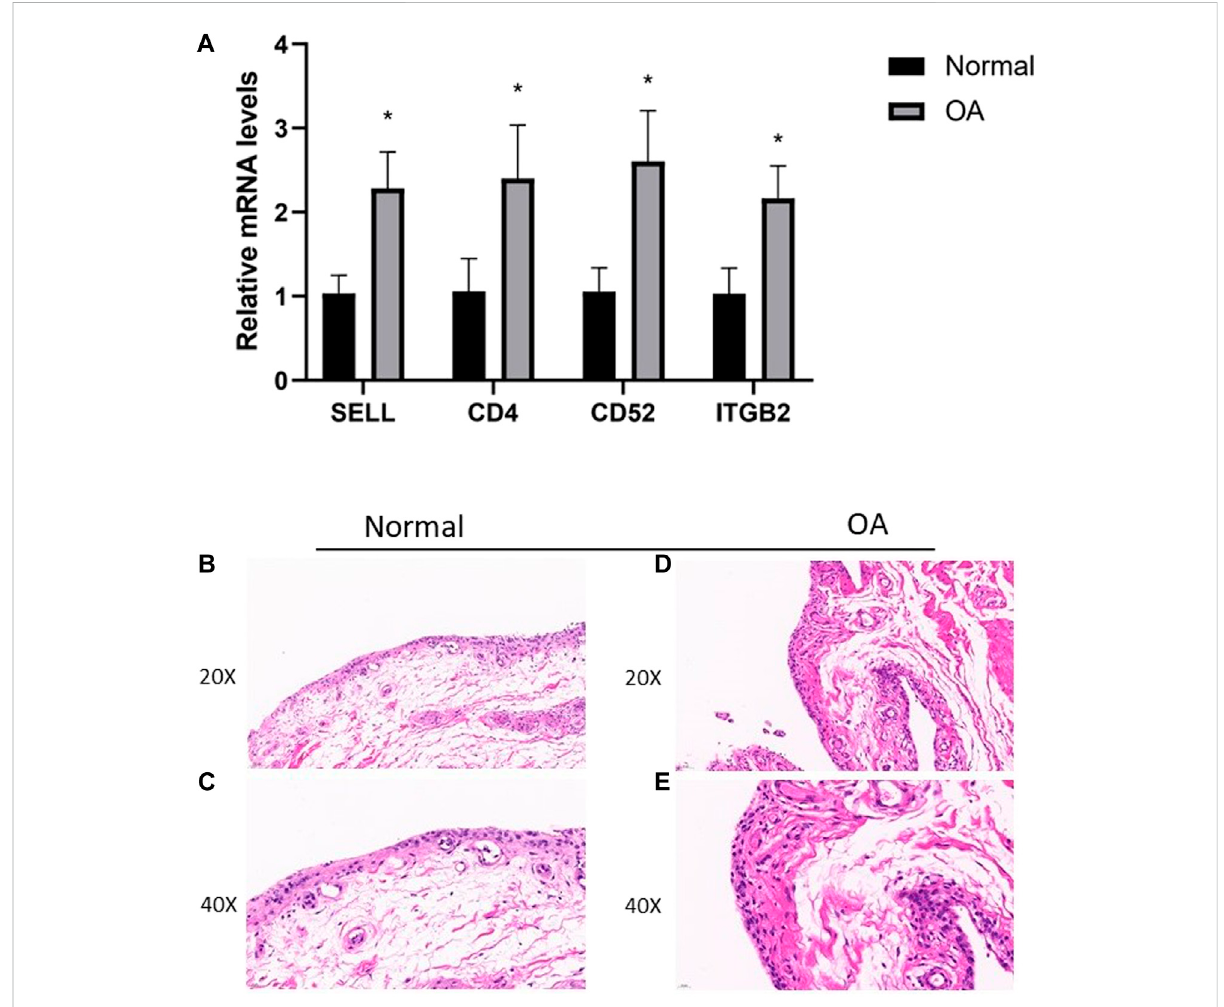
FIGURE 7 (A) RT-PCR validation of hub genes in human primary culture fi broblast-like synoviocytes between OA and normal controls. All experiments were performed thrice, and results were presented as M ± SD. ( p p < 0:05). (B – E) HE staining of synovial tissues from TKA patients and patients undergoing knee arthroscopic